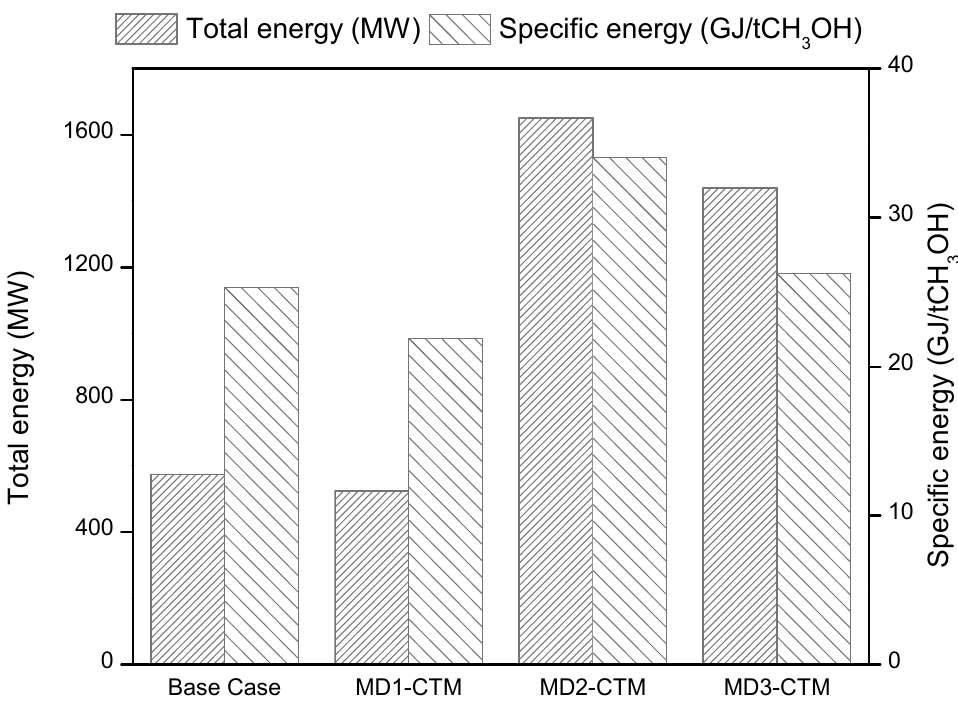
Figure 8. Total and specific energy requirement for the four CTM processes.